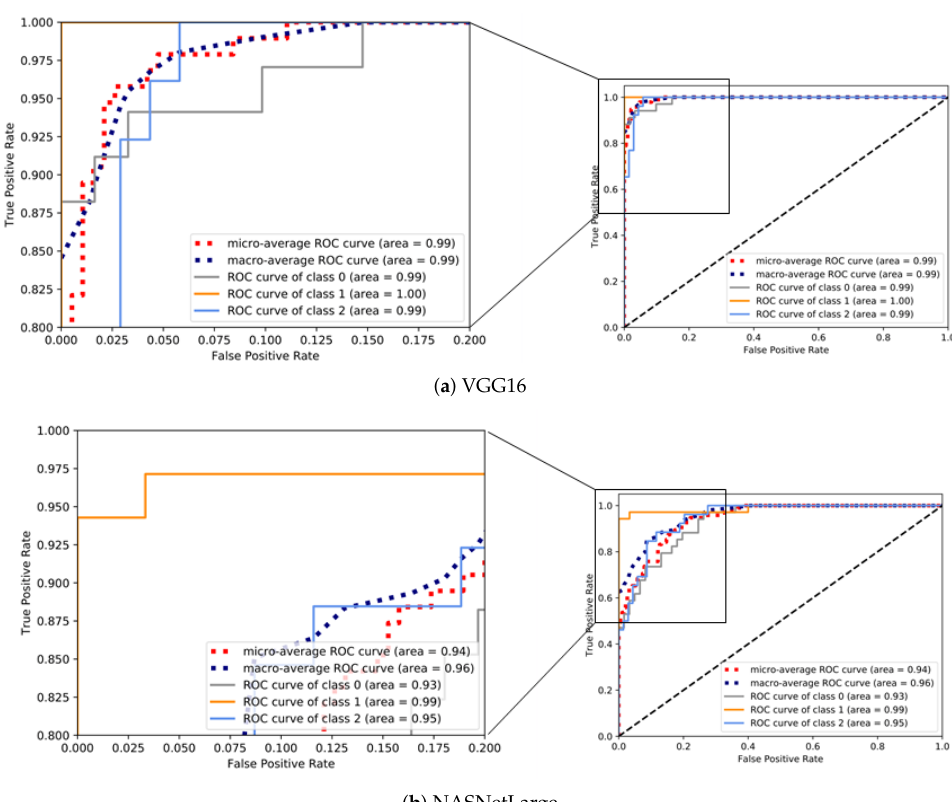
Figure 15. ROC curve of deep learning models for Pattern B.